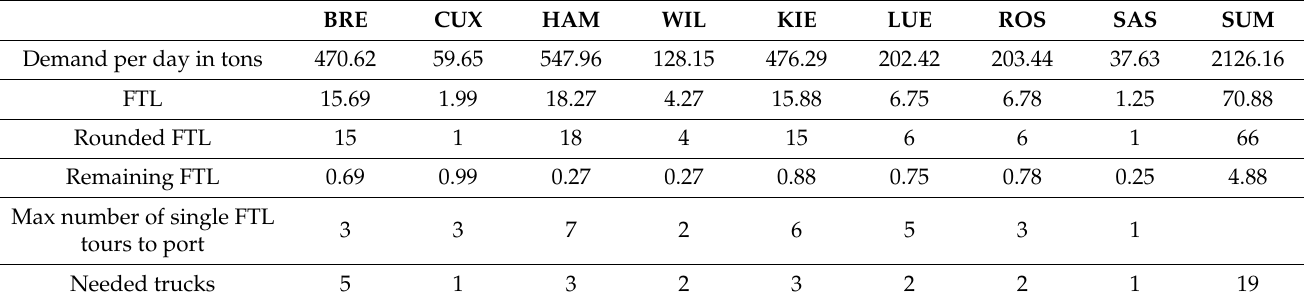
Table 4. Transport volumes of NH 3 and needed trucks of model B.